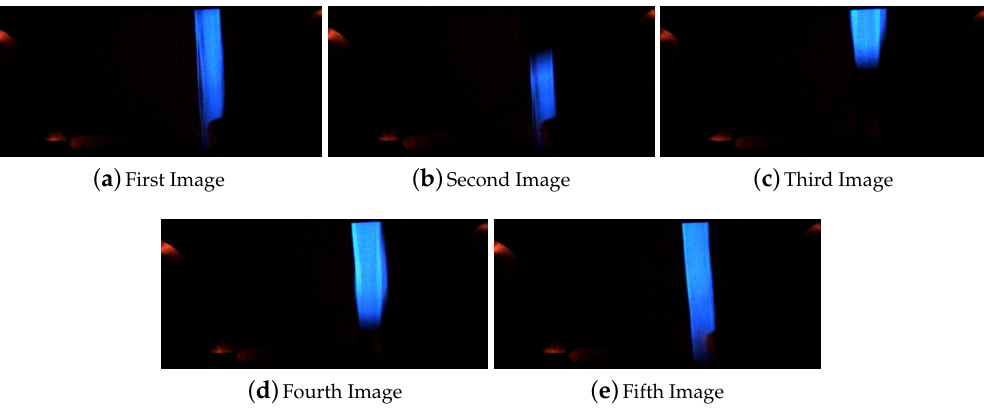
Figure 12. Sequence of images for the line occlusion for 30 cm inside a curve.